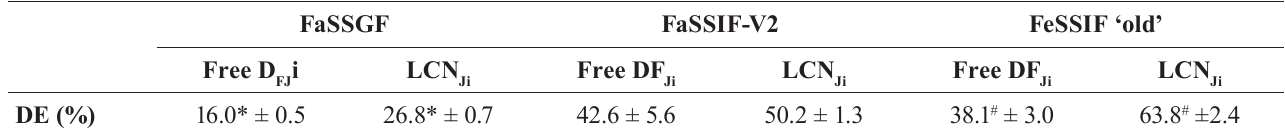
Table III - Dissolution efficiency values (DE%) calculated from the jatrophone release